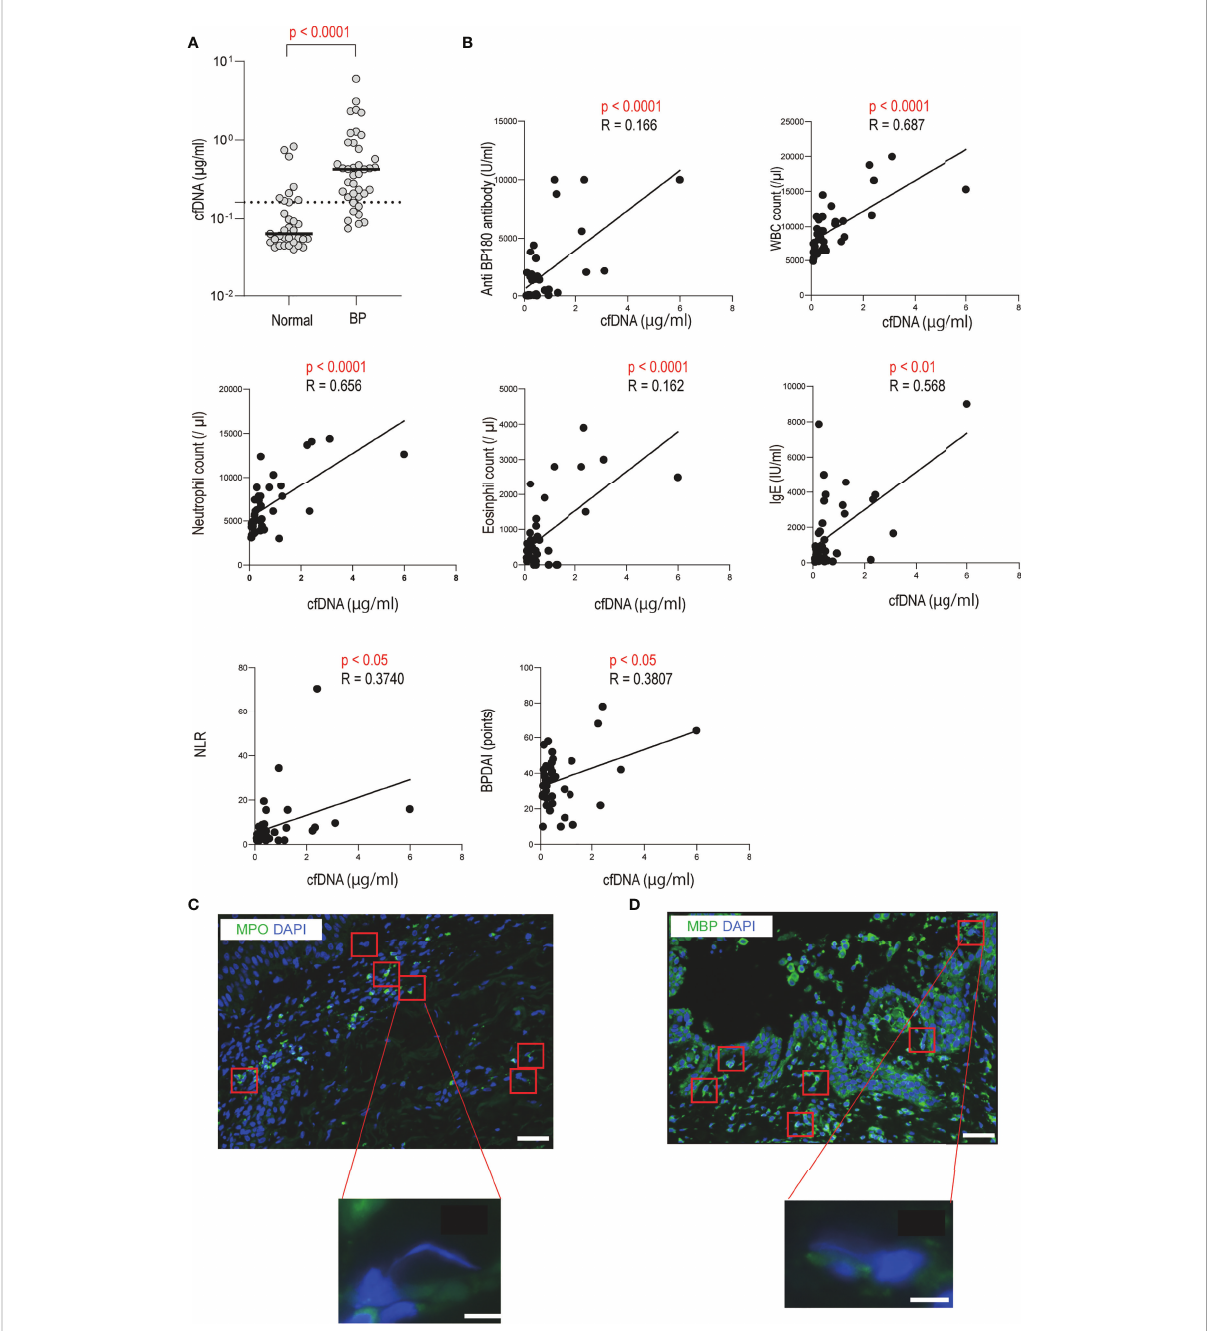
FIGURE 1 Increased serum cell-free DNA levels and identi fi cation of extracellular DNA-producing cells in BP patients (A) Serum cell-free DNA levels in BP patients (n = 39), and healthy controls (n = 33) were determined by a speci fi c enzyme-linked immunosorbent assay. The horizontal lines indicate the median values. The broken lines show the cut-off value (mean ± 2 SD of healthy controls). (B) Correlations between serum cell-free DNA levels and disease activity markers or BPDAI in BP patients. The solid lines indicate a linear regression line. (C, D) Immuno fl uorescence images for extracellular DNA in the skin sections of BP patients. Extracellular DNA was mostly located within and around subepidermal blisters. DAPI (blue) was used to visualize DNA together with (C) MPO (green) or (D) MBP (green). Higher magni fi cation images are shown below. Results are representative of six individuals. Scale bar, 50 m m in upper lower magni fi cation, and 5 m m in the lower higher magni fi cation,